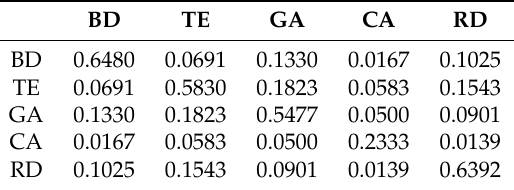
Table 3. Co-occurrence matrix of Vaihingen dataset. Building: BD, TE: Trees, GA: Grass, CA: Cars, RD: Road.